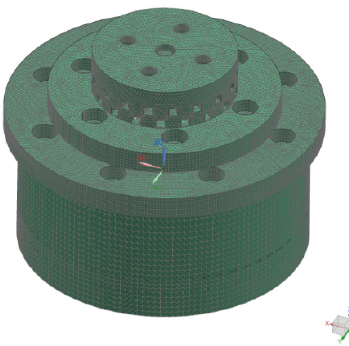
Figure 6. Mesh generation results of the idealized model.